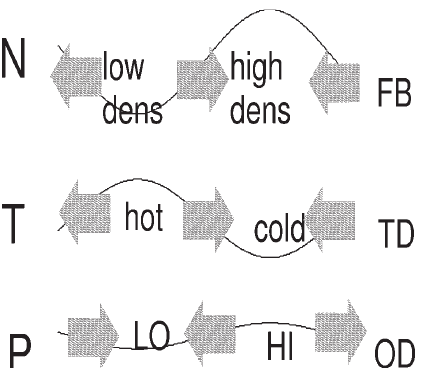
Fig. 3. Diagram showing the particle fluxes produced by the Farley- Buneman process in the density wave ( top ), by thermal di(cid:128)usion in the temperature wave ( middle ) and by ordinary di(cid:128)usion in the pressure wave ( bottom ). This sketch is valid for hard-sphere types of elastic collisions and zero aspect